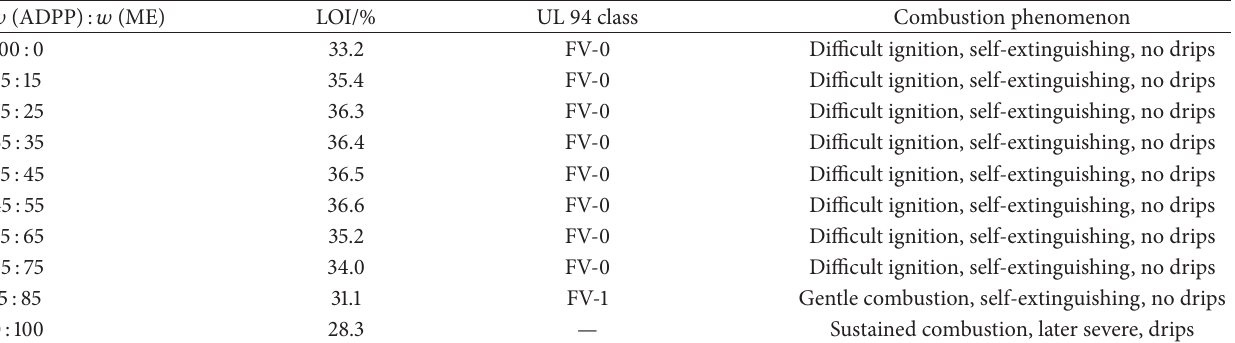
Table 1: Effect of the weight ratios of ADPP to Me on its flame retardance in PA6.